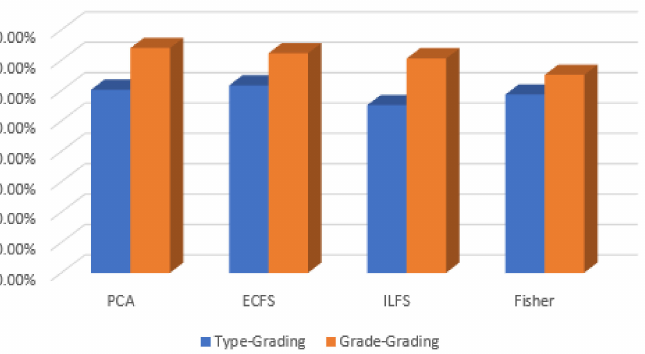
Figure 31. Accuracy for the 50 most significant features for severity grading and type grading employing automatic